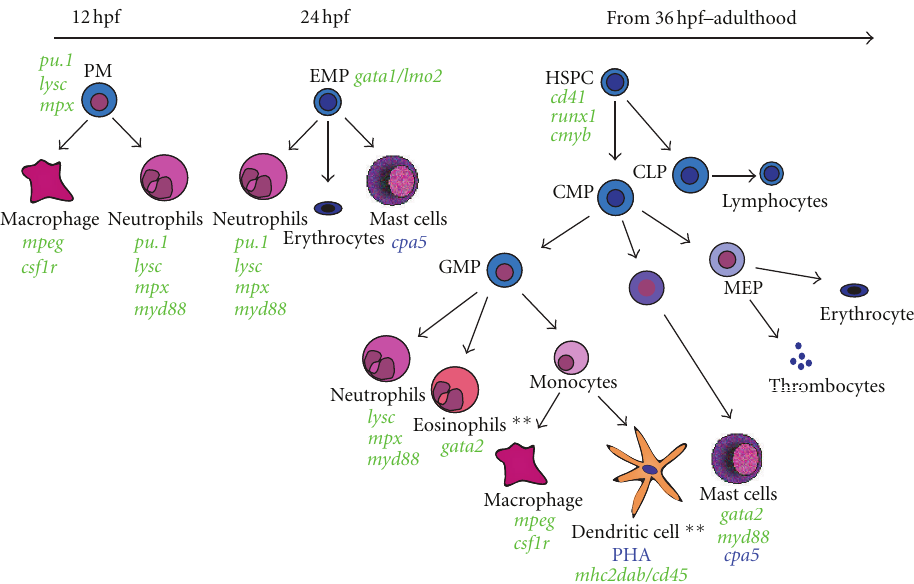
Figure 1: Overview of zebrafish developmental myelopoiesis, key transgenic lines, and lineage identification tools labelling myeloid cell populations during developmental haematopoiesis. (Transgenic lines are shown in green, other specific lineage identifiers are in blue.) PM: primitive myelopoiesis; EMP: erythromyeloid progenitors; HSPCs: haematopoietic stem and progenitor cells; CMP: common myeloid progenitor; CLP: common lymphoid progenitor; MEP: megakaryocyte/erythroid progenitor; GMP: granulocyte/monocyte progenitor; PHA: peanut haemaglutinin. ∗∗ Denotes lineages only demonstrated in adult zebrafish. Lineage intermediates are shown for clarity but are yet to be isolated as distinct populations in